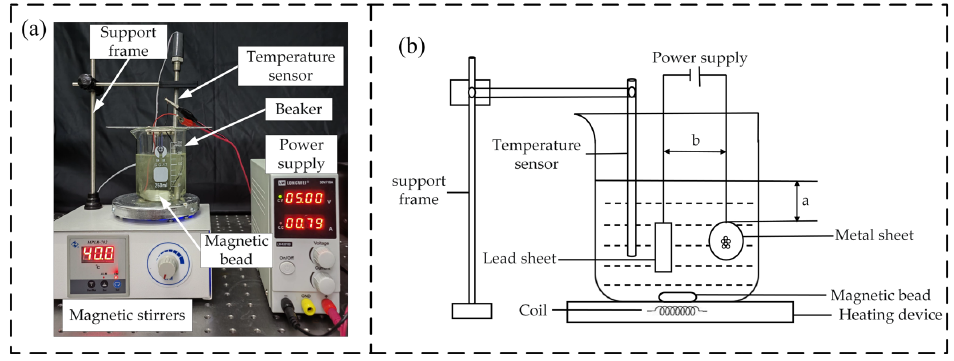
Figure 2. Experimental diagram of electrolytic polishing: ( a ) Picture of real products; ( b ) Schematic.